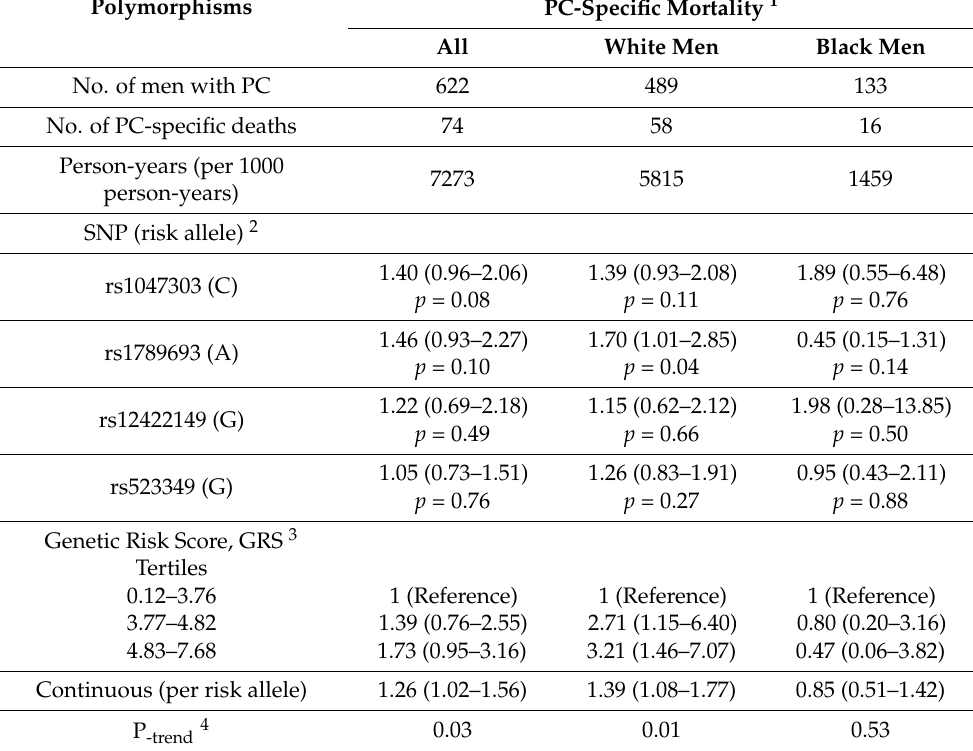
Table 3. Associations between SNPs located in the androgen-regulating genes and PC-specific mortality in Black and White men with PC; ARIC 1987–2019. Hazard Ratio and 95% Confidence Intervals Polymorphisms